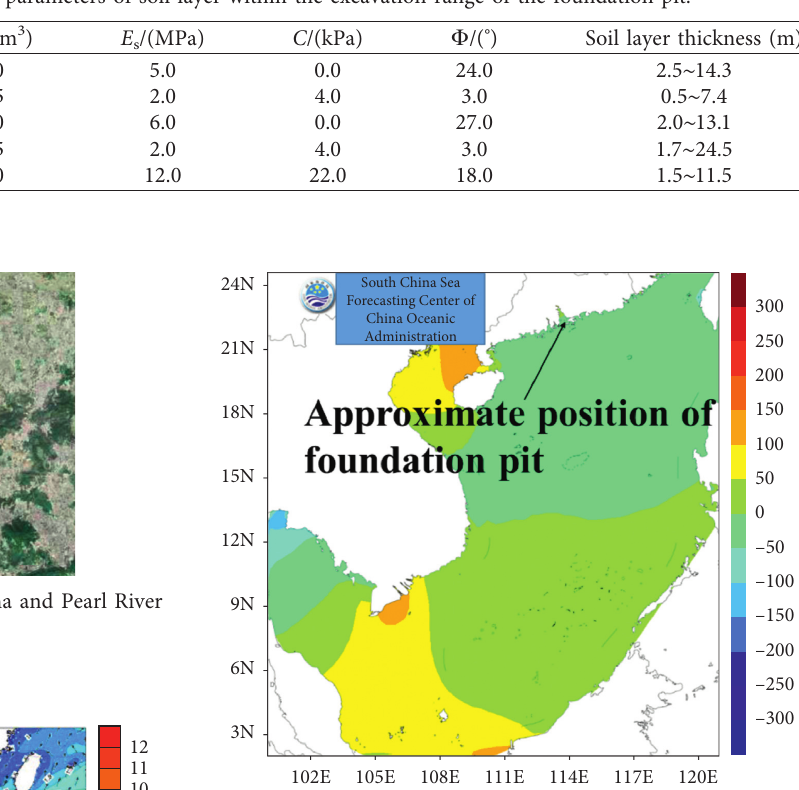
Figure 7: Tidal water level map of the South China Sea (unit: cm).